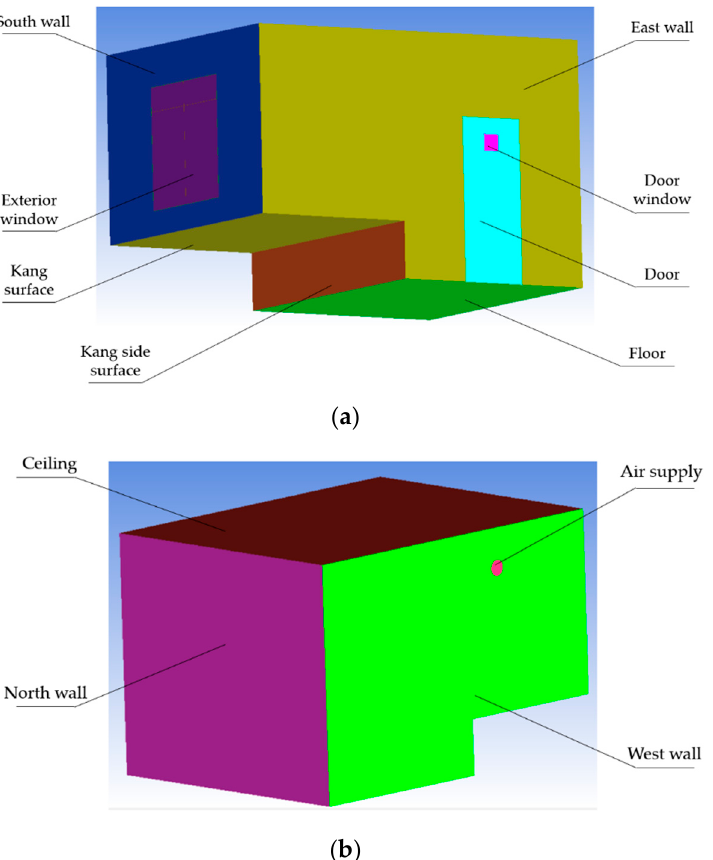
Figure 7. The geometric model of the experiment room, ( a ) southeast view, ( b ) Northwest view.